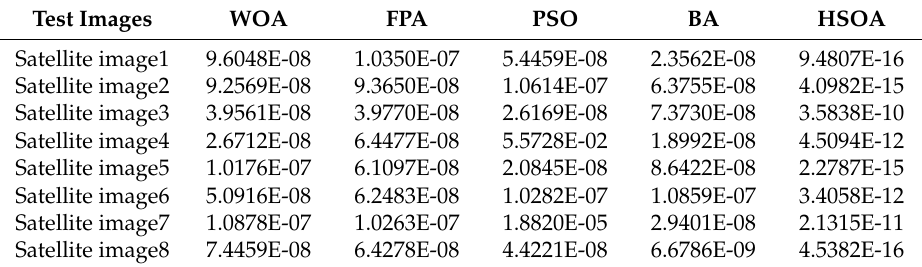
Table 3. Comparison of standard deviation (STD) of FSIM computed by WOA, FPA, PSO, BA, and